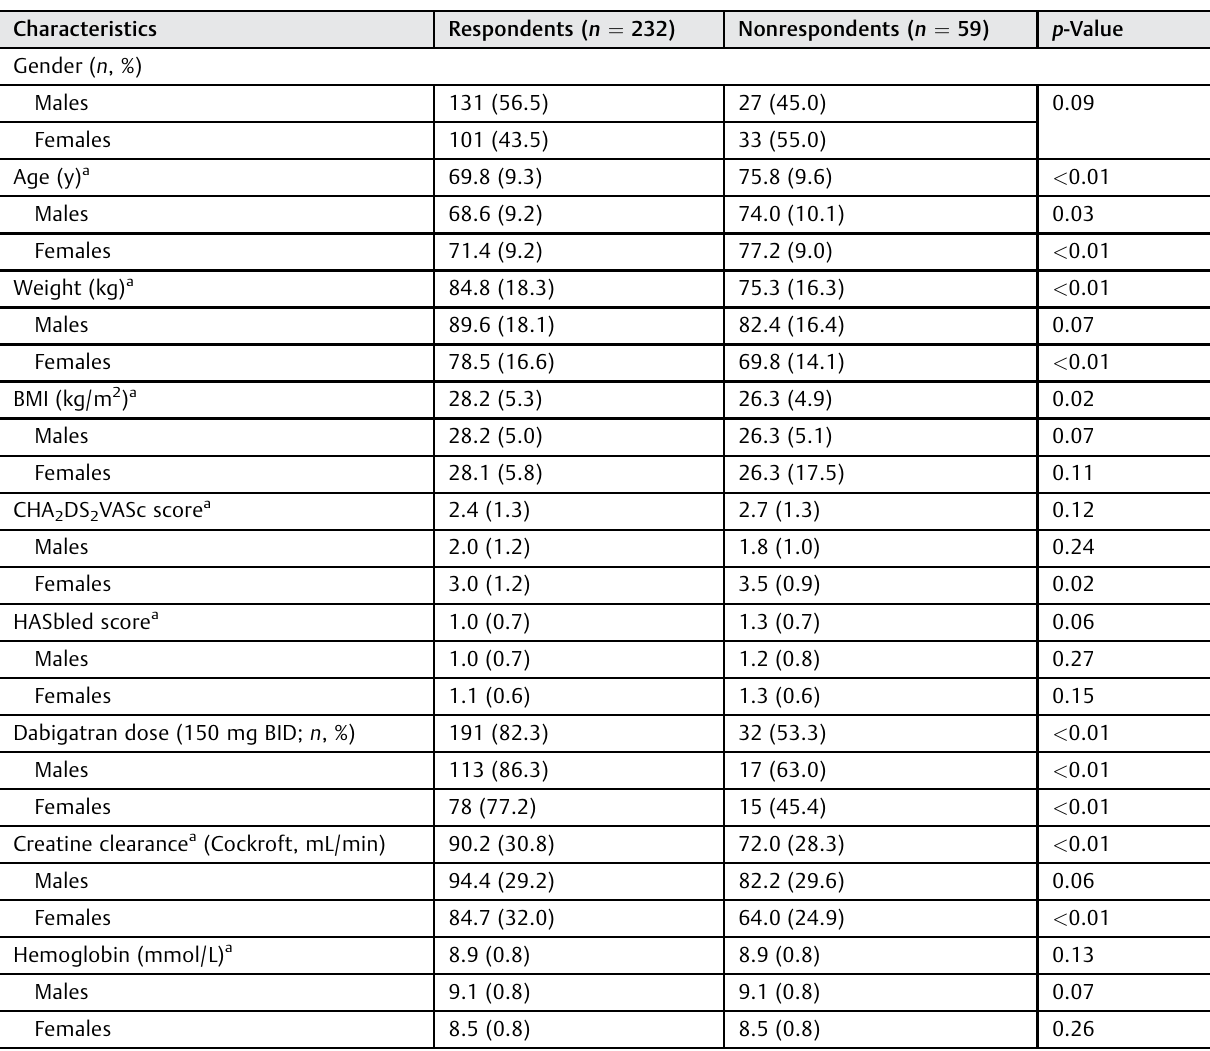
Table 1 Clinical characteristics of the study population Characteristics